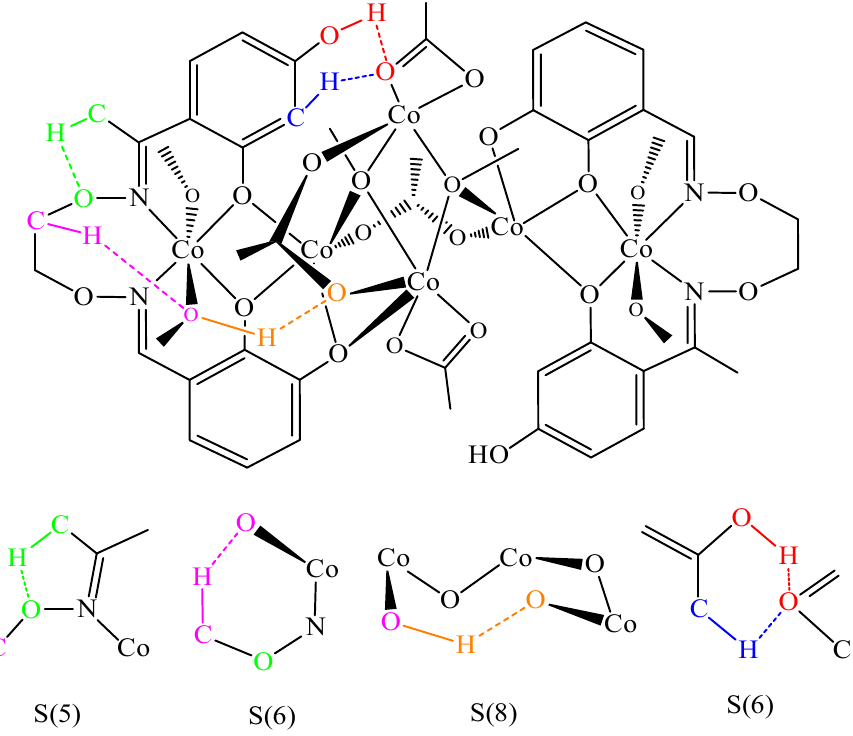
Figure 4. Graph set assignments for the Co(II) coordination compound.